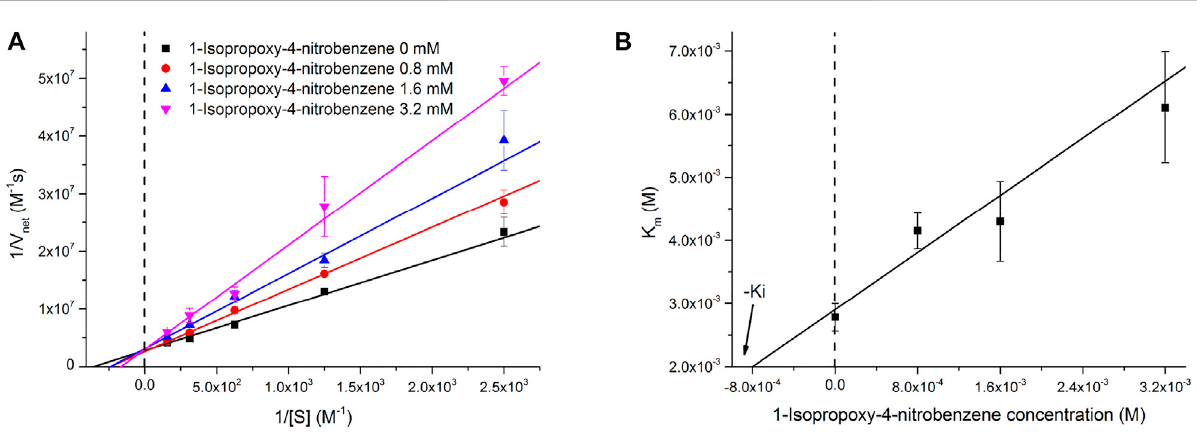
FIGURE 6 (A) Lineweaver-Burke plots of the hydrolysis of pNPA catalyzed by 0.1 mM of RADA16H 2 at 25 ° C in the presence of INB as inhibitor. These plots are straight lines with similar slopes suggesting a competitive inhibition of RADA16H 2 with INB. (B) Dixon plot for the inhibitory effect of INB on the RADA16H 2 catalysis